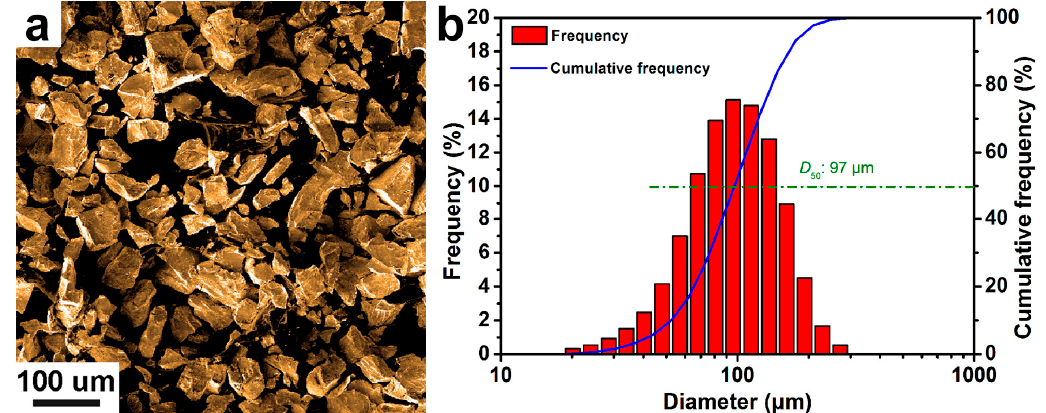
Figure 2. ( a ) SEM image and ( b ) diameter distribution of the Fe–Si–Al powder.